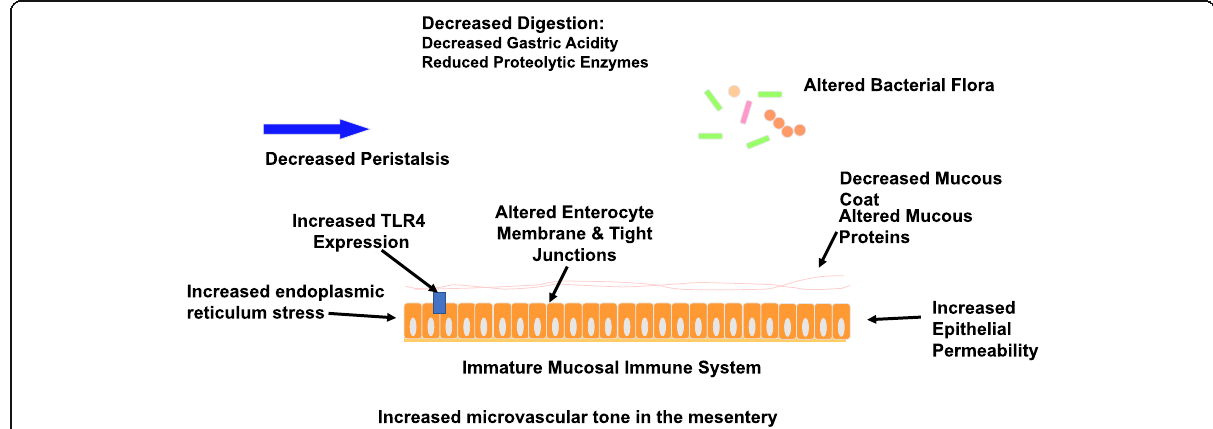
Fig. 2 Factors that Predispose the Immature Gut to Necrotizing Enterocolitis. Pictorial representation of factors contributing to the propensity of the immature gut to develop necrotizing